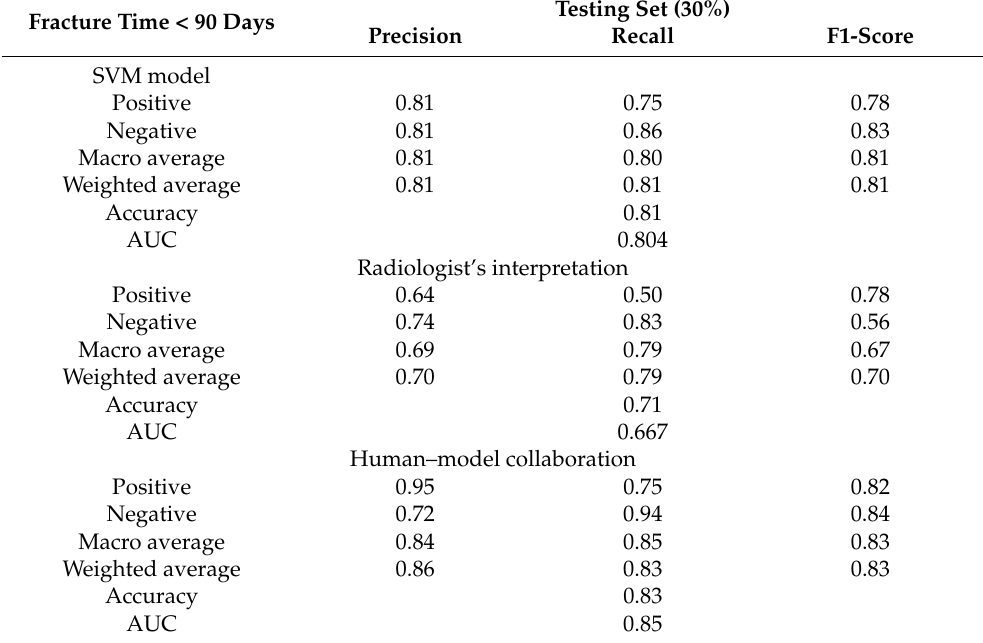
Table 3. Performances of the radiomics-based model, radiologist’s interpretation, and human–model collaboration for the testing set in predicting rib fracture at 90